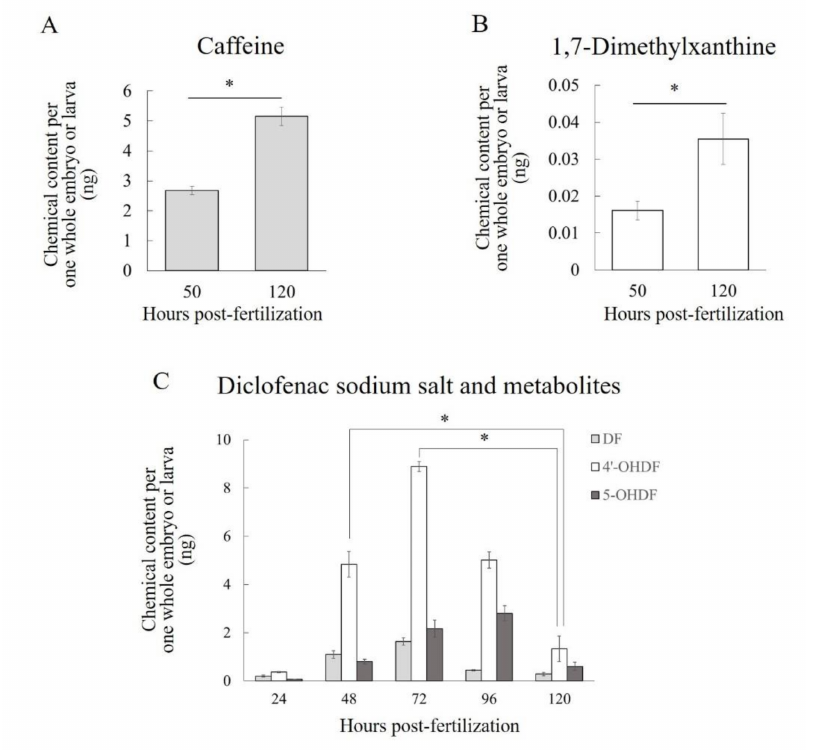
Figure 6. Contents of ( A ) ca ff eine, ( B ) 1,7-dimethylxanthine, and ( C ) diclofenac sodium salt (DF), 4 (cid:48) -hydroxydiclofenac (4 (cid:48) -OHDF), and 5-hydroxydiclofenac (5-OHDF) per one whole embryo or larva during exposure to each test compound. Each bar shows the mean value of three replicates. Each error bar shows the standard deviation of the replicates. Significant di ff erences between two specific data points, as determined by a two-tailed t -test, are shown by asterisks ( p < 0.05). Statistical analyses were performed only for the specific sets of data points shown by the